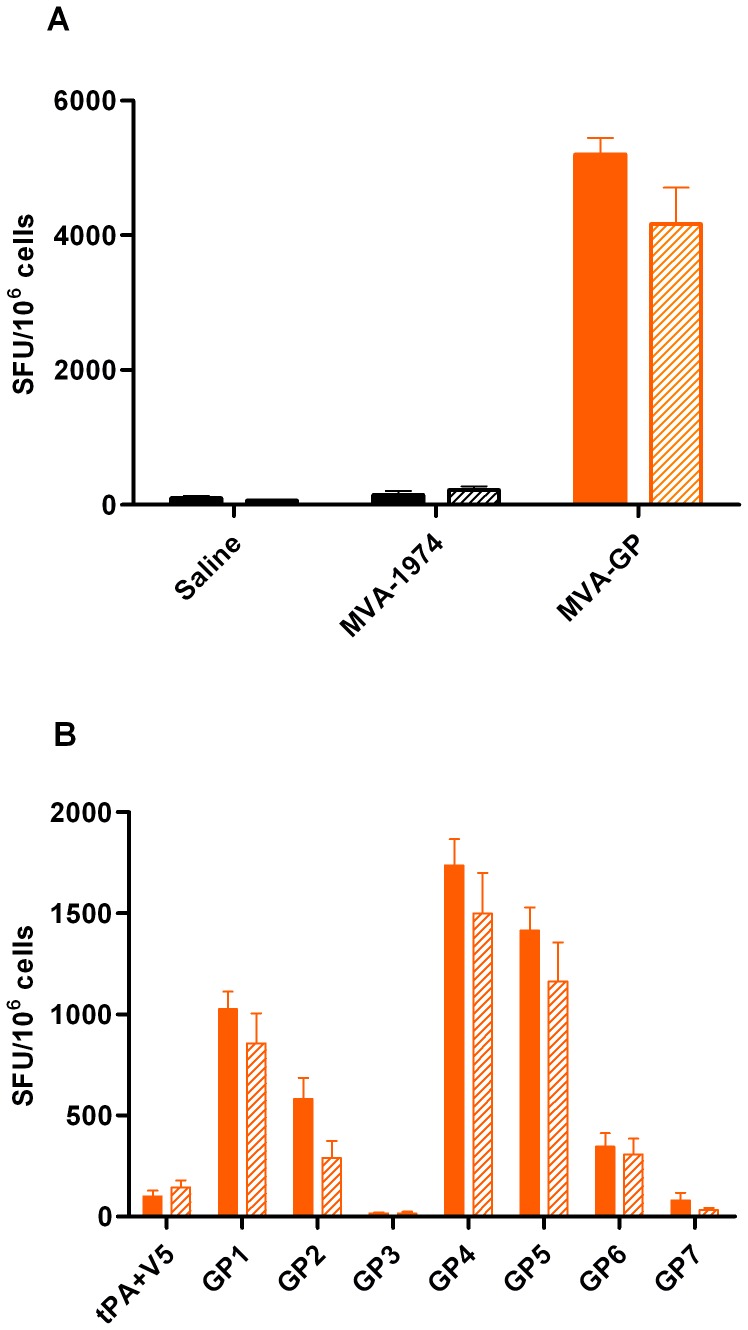
IFN-γ ELISpot responses from vaccinated A129 and 129Sv/Ev mice, 7 days after booster vaccination.Splenocytes from animals vaccinated with MVA-GP (orange), MVA 1974 or saline (black) were restimulated with peptides derived from the CCHFv glycoprotein. A129 mice data (solid bars) were pooled from 2 independent experiments (n = 8). 129Sv/Ev mice n = 5 (hatched bars). Mean ± SEM is plotted. (A) Summed antigen responses from all peptide pools. Splenocytes from MVA-GP vaccinated mice, but not control mice, responded to GP-specific peptides, indicating similar T-cell responses between mouse strains. (B) Antigen responses from MVA-GP vaccinated mice, according to peptide pool. Immunogenicity was not evenly distributed across the antigen, but some peptide pools were more immunogenic than others. Responses were specific to the glycoprotein, and similar between mouse strains.